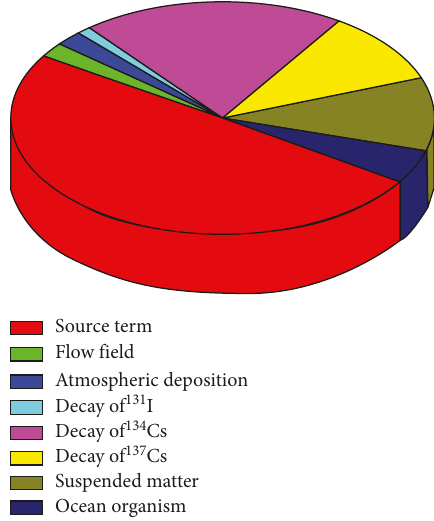
Figure 10: The mechanism of long-term radionuclide diffusion in the ocean.